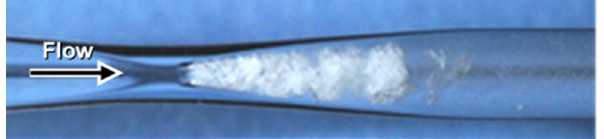
Figure 2. Aspect of cavitation through Venturi tube [47].